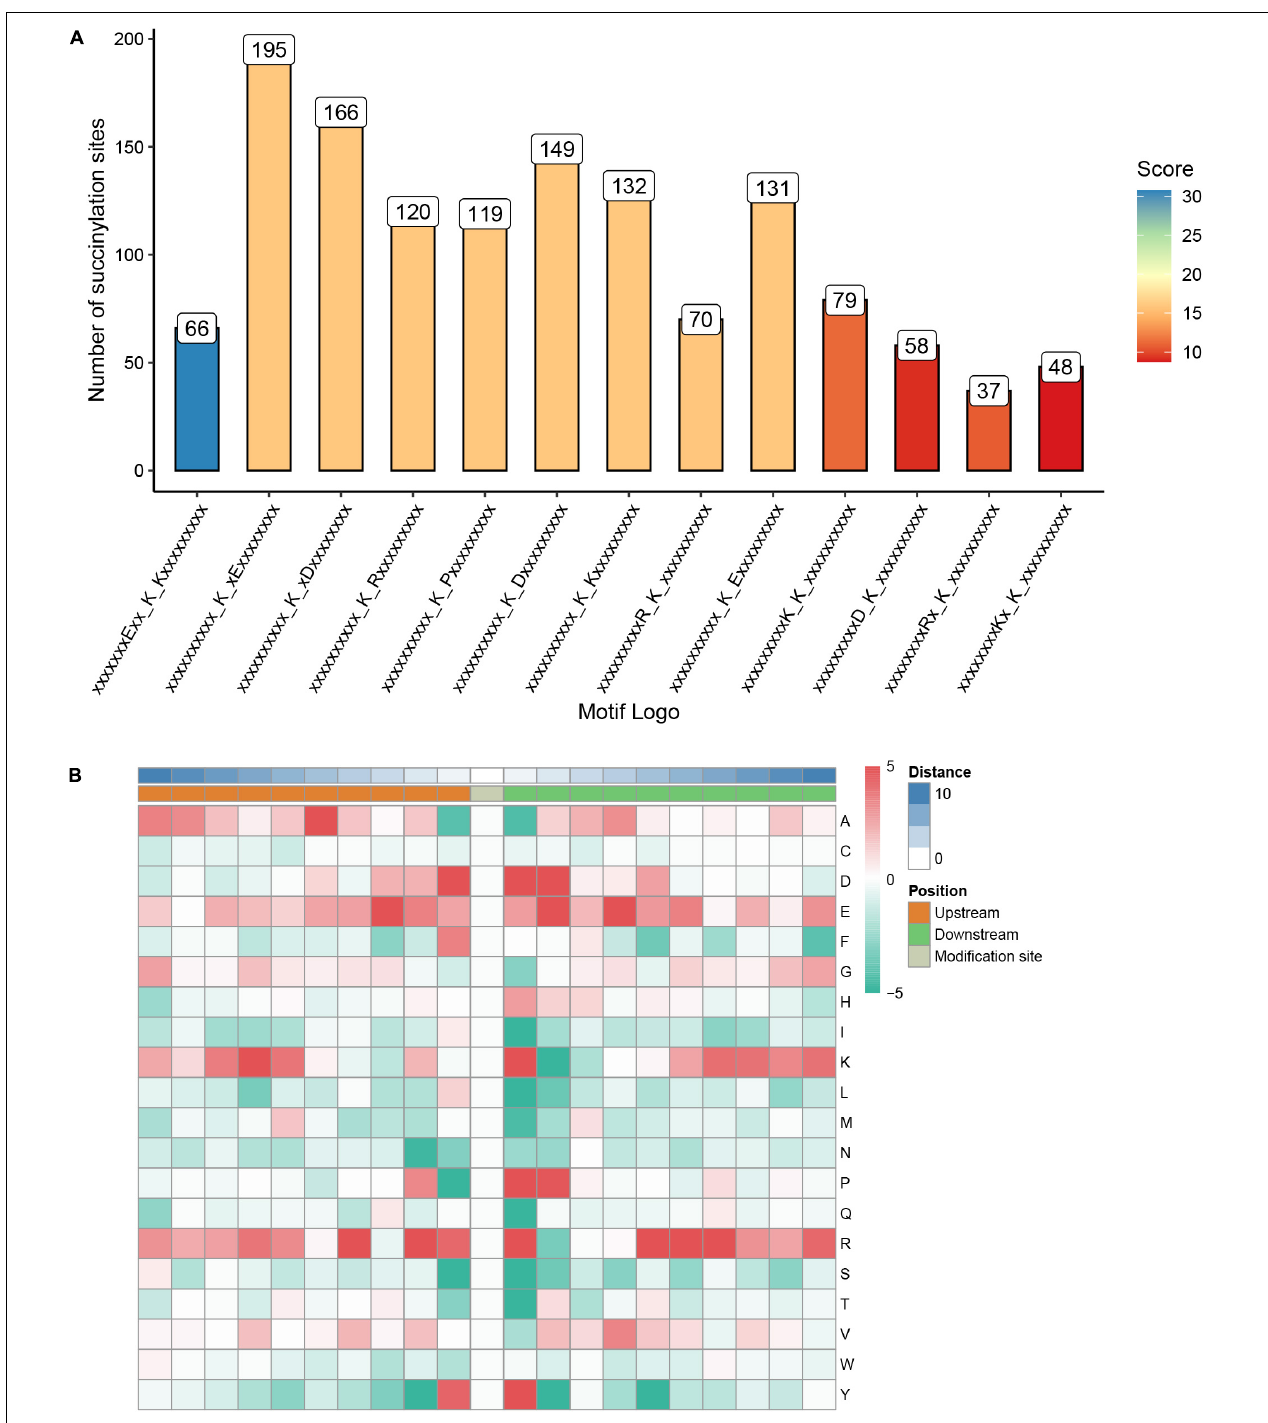
FIGURE 5 | Properties of the succinylated peptides in Staphylococcus epidermidis. (A) The number of peptides with each of these 13 motifs. (B) A heat map of amino acid compositions surrounding the succinylated lysine.